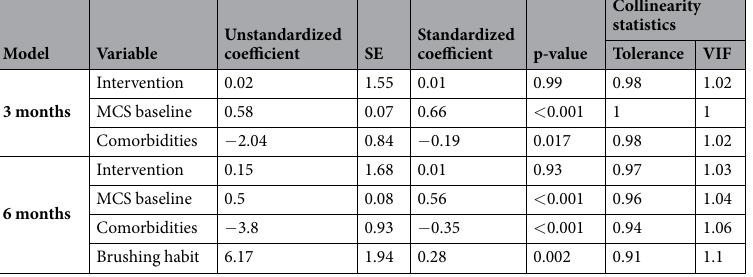
Table 5. Factors associated with MCS scores (linear regression model). 3-month model: adjusted R square = 0.45. 6-month model: adjusted R square =